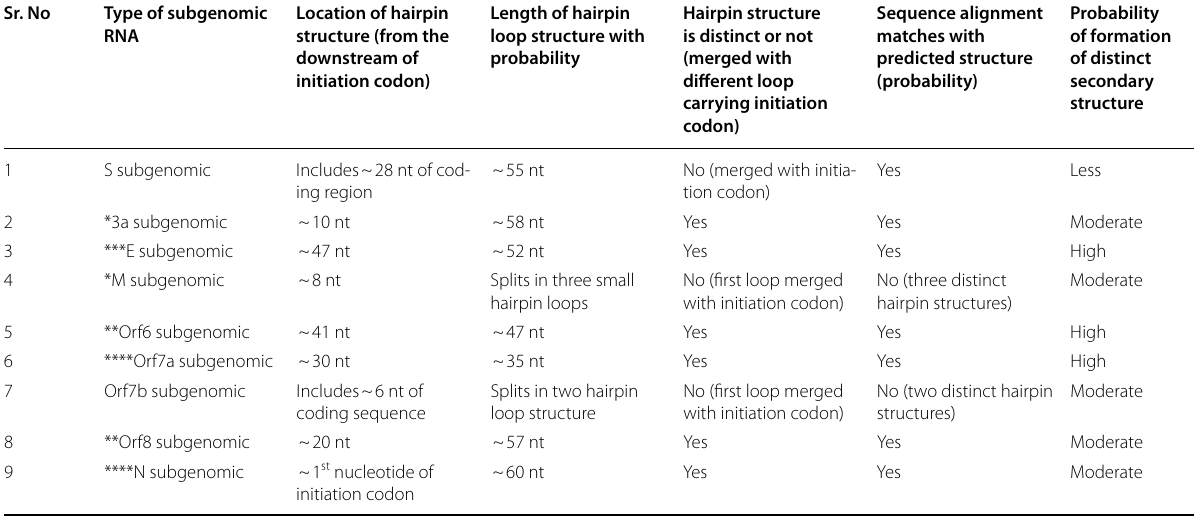
The description is drawn from the combined output of sequence alignment followed by secondary structure prediction results. The number of asterisks (*) denotes to the abundance level for each subgenomic RNA detected by NGS reads mapped to the sequences, and no asterisk is given to particular subgenomic that was detected at very low or near zero level according to previous finding (Alexandersen et al. 2020). Single asterisk denotes low, two and three asterisk denotes moderate and four asterisk denotes high abundance of particular subgenomic RNA (in relative context)